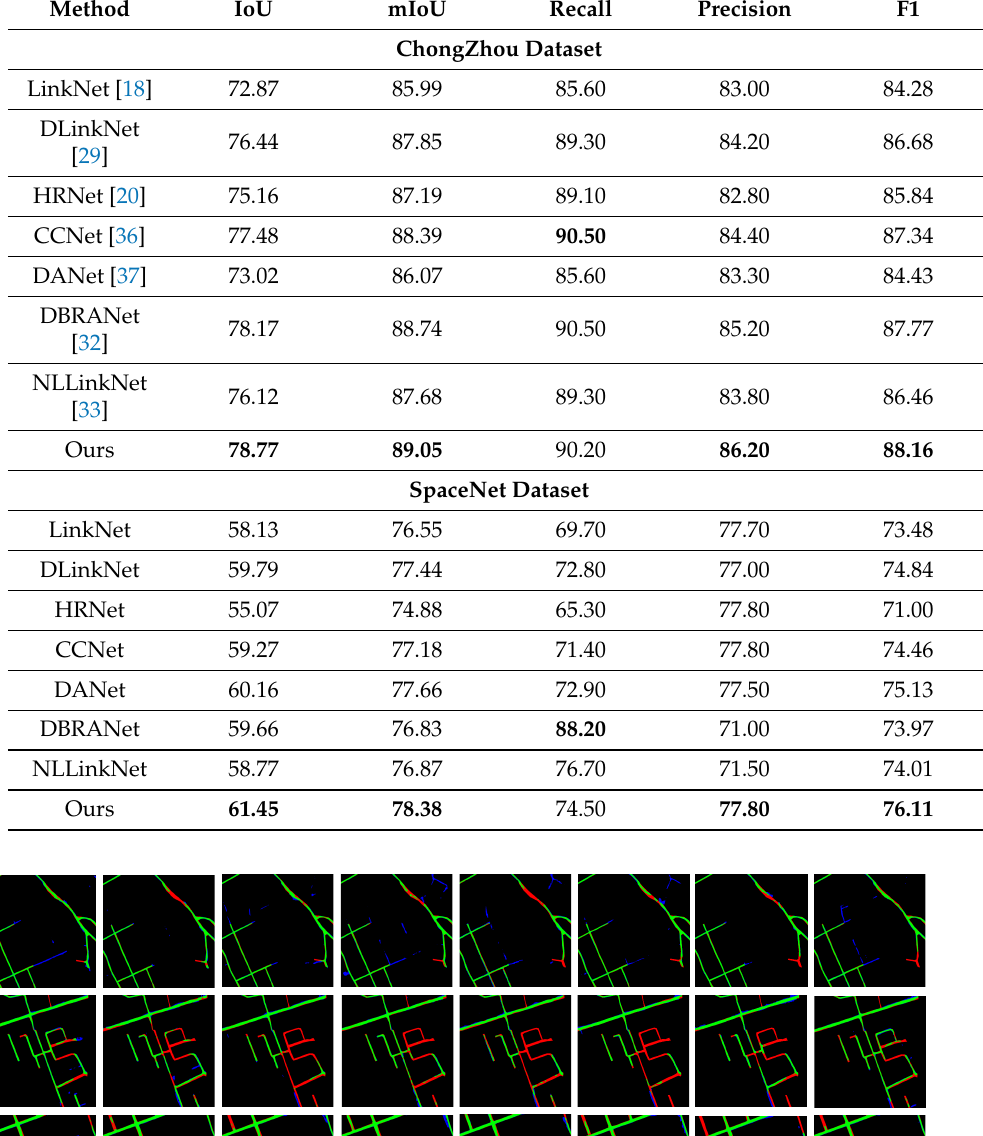
Table 3. Evaluation results obtained by IoU (%), mIoU (%), F1-score (%), precision (%) and recall (%) on the Chongzhou and SpaceNet datasets. Best results are shown in bold.